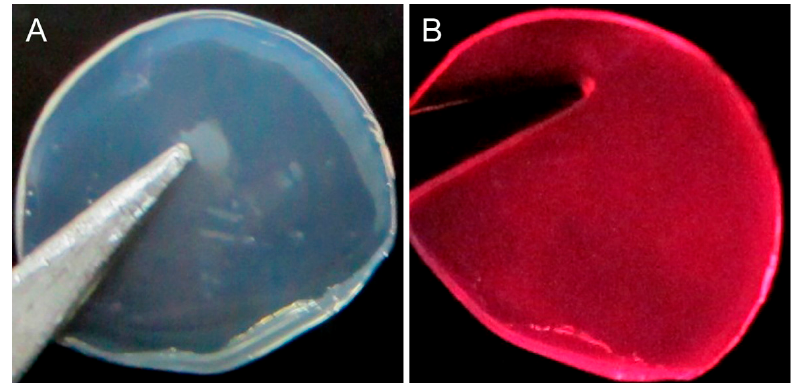
Figure 8. Photographs showing the as-prepared AuNCs-involved membrane, which can be used as a solid probe for the detection of H 2 O 2 : ( A ) under sunlight; ( B ) under UV light (365 nm).